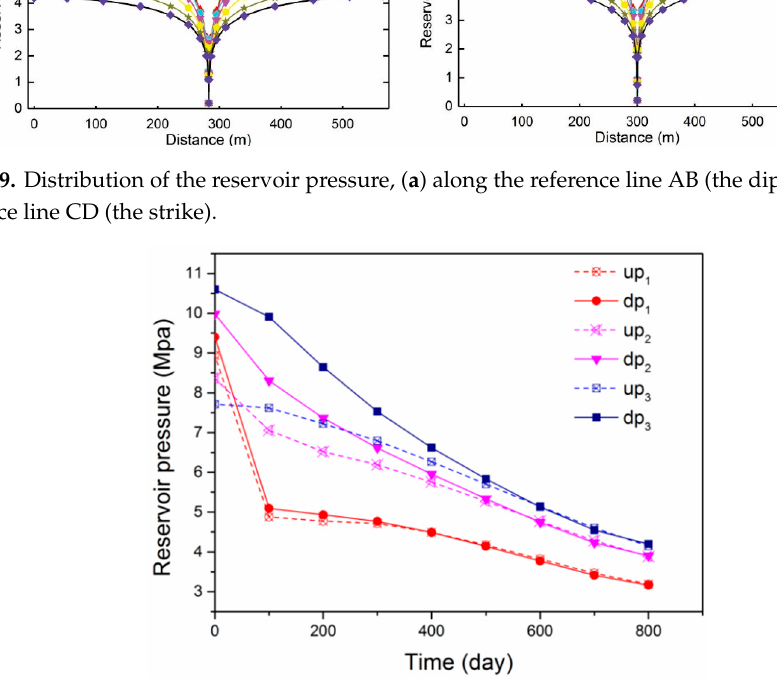
Figure 10. Pressure evolution of the reservoir at different points.